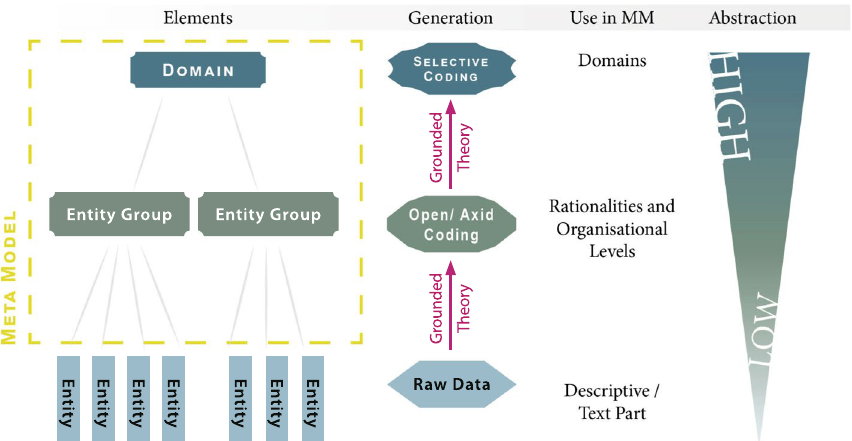
Fig. 3 Development of the elements of the metamodel (Source: Matthias Ripp)